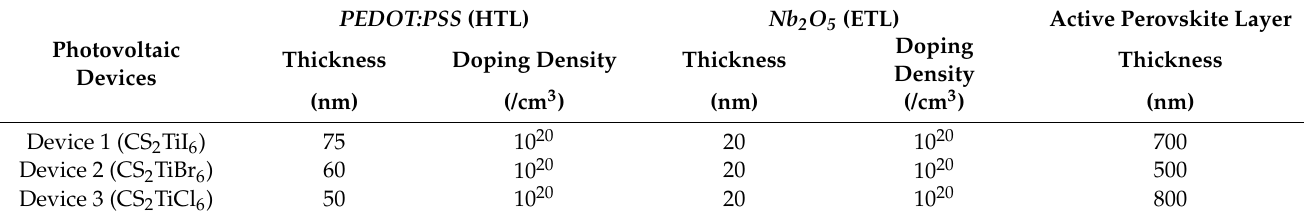
Table 3. The overall optimization parameters (thickness and doping density) of hole-transport, elec- tron-transport, and active perovskite layer for proposed photovoltaic devices.